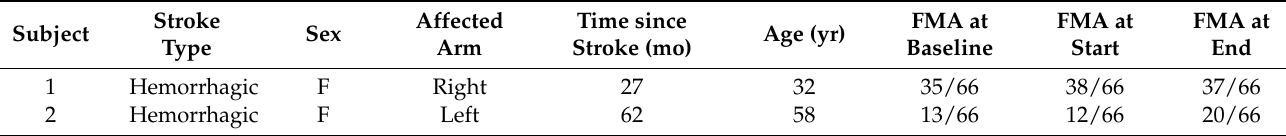
Table 3. Stroke subject characteristics and Fugl-Meyer Assessment (FMA) for upper extremity.